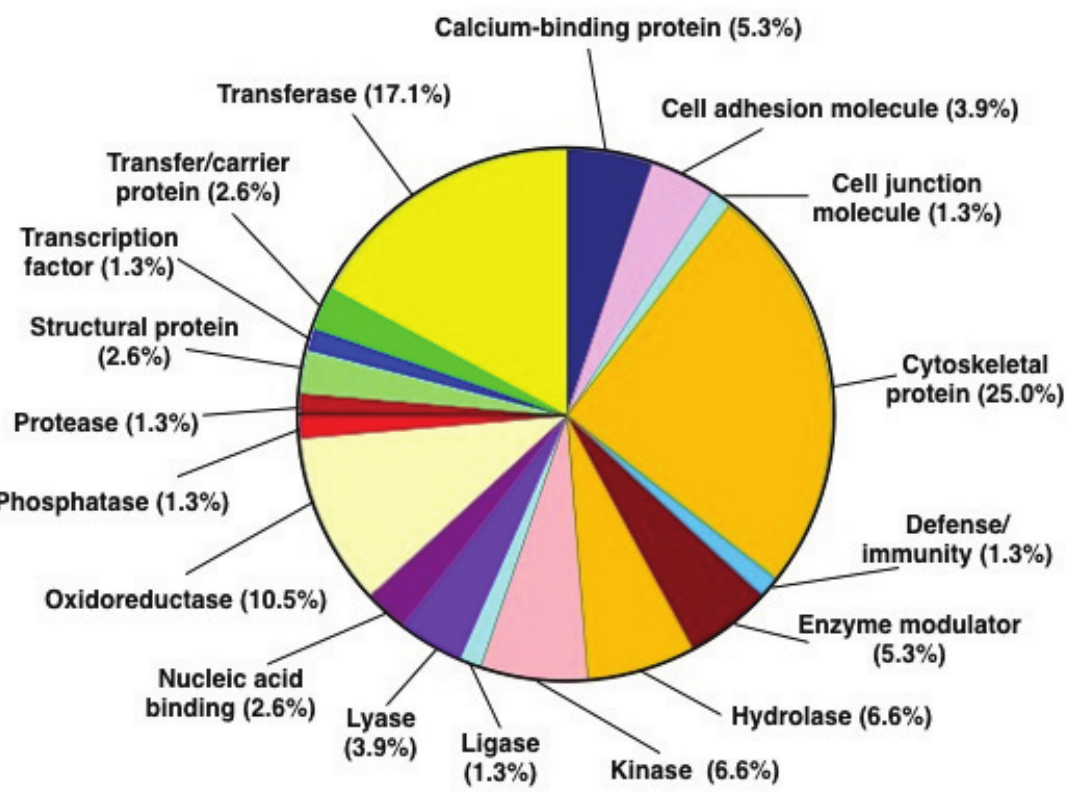
Figure 4. Summary of changed protein classes with a reduced abundance in mdx-4cv hind limb muscle. The bioinformatics software programme PANTHER [57,58] was applied to identify the clustering of protein classes based on the mass spectrometric analysis of the microsomal fraction from dystrophic versus control specimens (Tables 1 and